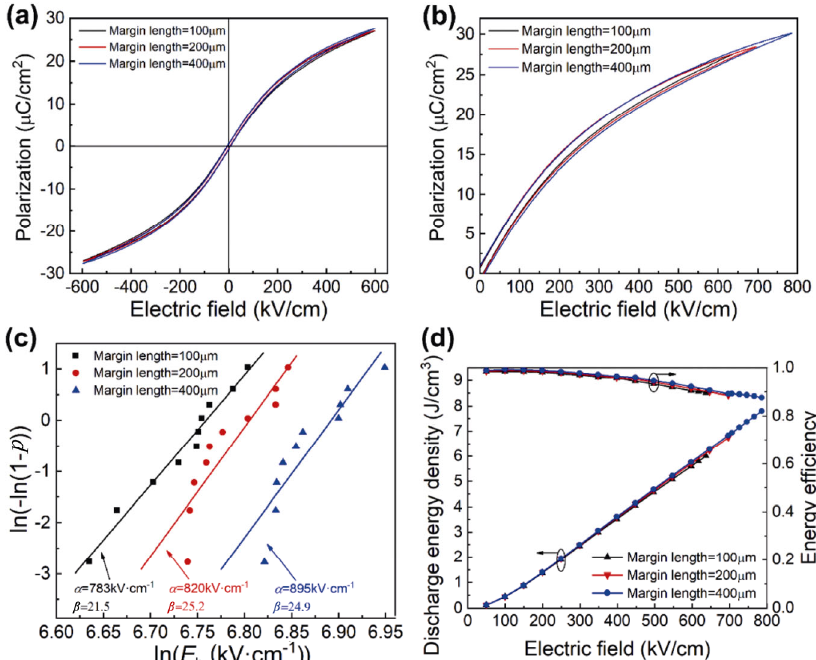
Fig. 25 (a) Hysteresis loops of MLCCs with various margin lengths measured under an applied electric field of 60 MV·m –1 at 1 Hz. (b) Unipolar hysteresis loops of the MLCCs with various margin lengths under their own AC breakdown strength at 1 Hz. (c) Weibull plots of the DC dielectric breakdown strength for MLCCs with various margin lengths. (d) Calculated recoverable energy density and energy efficiency of MLCCs with various margin lengths as a function of the applied electric field, measured at 1 Hz. Reproduced with permission from Ref. [121], © Author(s)